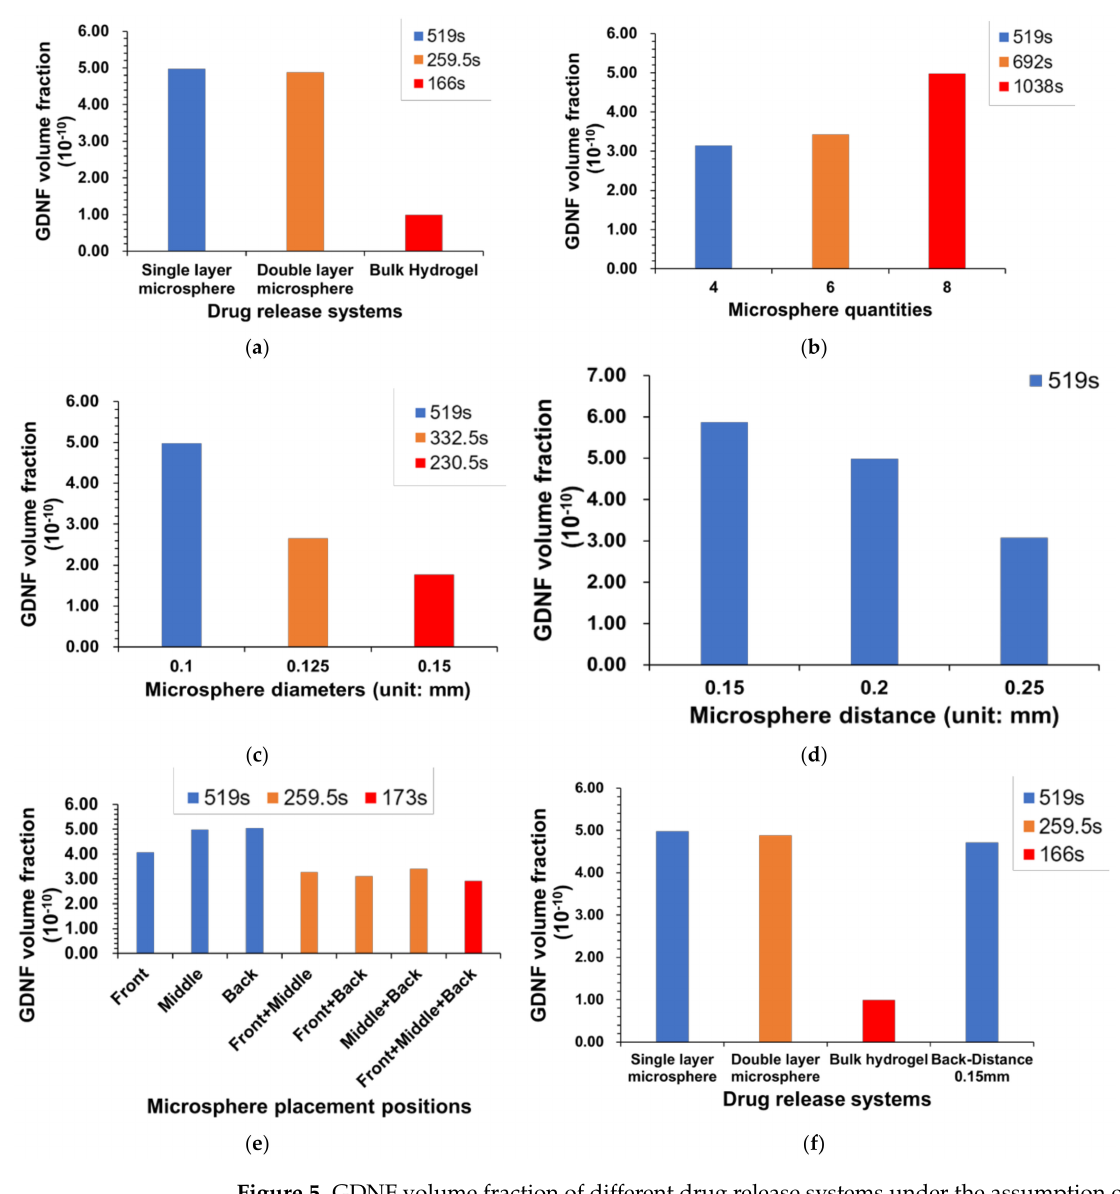
Figure 5. GDNF volume fraction of different drug release systems under the assumption of constant growth factor mass. ( a ) Comparison among single- and double-layer microsphere and bulk hydrogel systems. ( b – e ) Comparison within single-layer microsphere only. ( f ) Comparison between three drug release systems and the combined model.